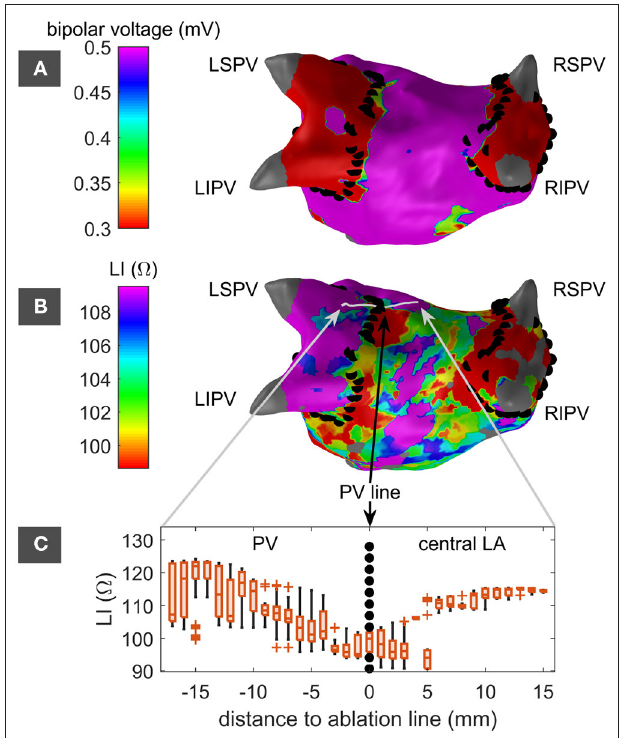
FIGURE 6 | Distribution of LI upEn for an exemplary patient with previous PVI (A) and an exemplary control patient (B) for the RPVI and LPVI region of 5mm width as well as the respective margins of 10mm width. The difference in median LI upEn between the RPVI region and the RPVI margin as well as the LPVI region and the LPVI margin is summarized for all PVI patients (C) and all control patients (D) for different widths of the PVI regions and the margins in the lower panels. Colors indicate the elevation of LI upEn within the margin compared to the PVI line with negative or small elevations in blue and large elevations in yellow. The black crosses mark the widths of 5 and 10mm for PVI region and PVI margin as chosen for the exemplary distributions in (A) and (B) . Asterisks (*) denote statistically significant difference between distributions. LI, local impedance; RPVI, right pulmonary vein isolation; LPVI, left pulmonary vein isolation; PVI, plumonary vein